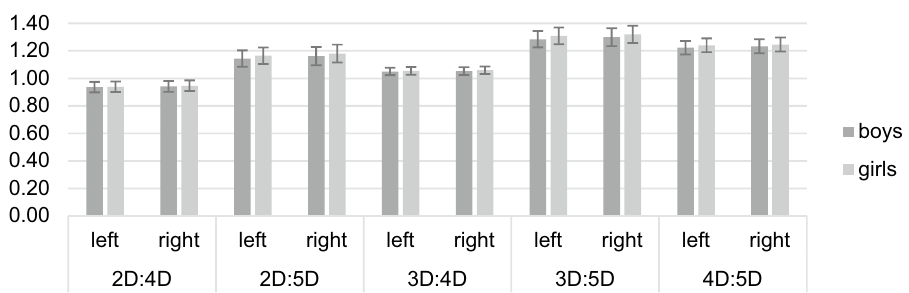
Figure 3. Means and standard deviations in right, left, and averaged digit ratios separately for boys and